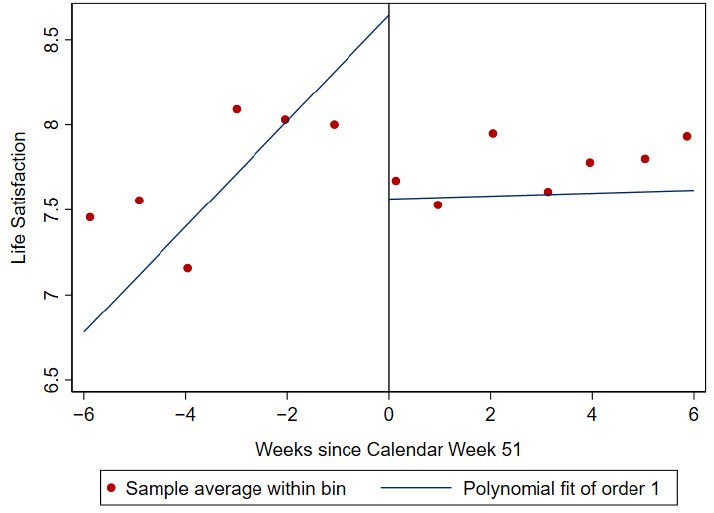
Figure 4. RD plot. Figure 4. RD plot. The plot indicates that life satisfaction decreased when the lockdown was introduced.